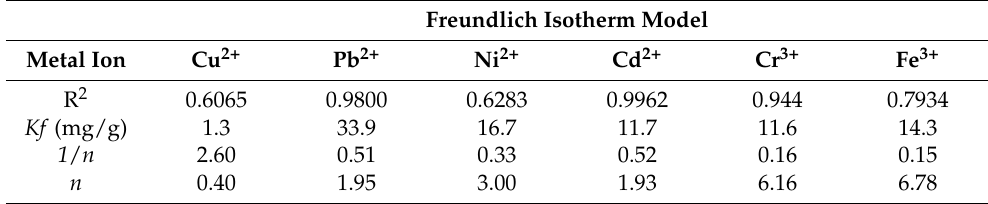
Table 6. Freundlich constants for adsorption of the M X+ onto MS